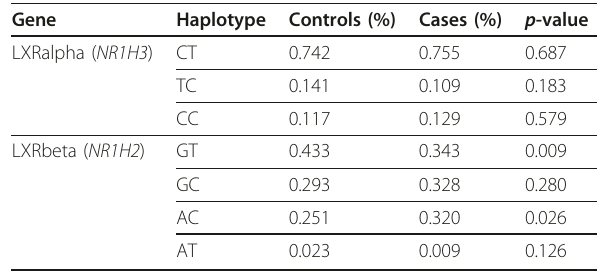
Haplotype frequencies were compared between cases and controls, in chi- squared